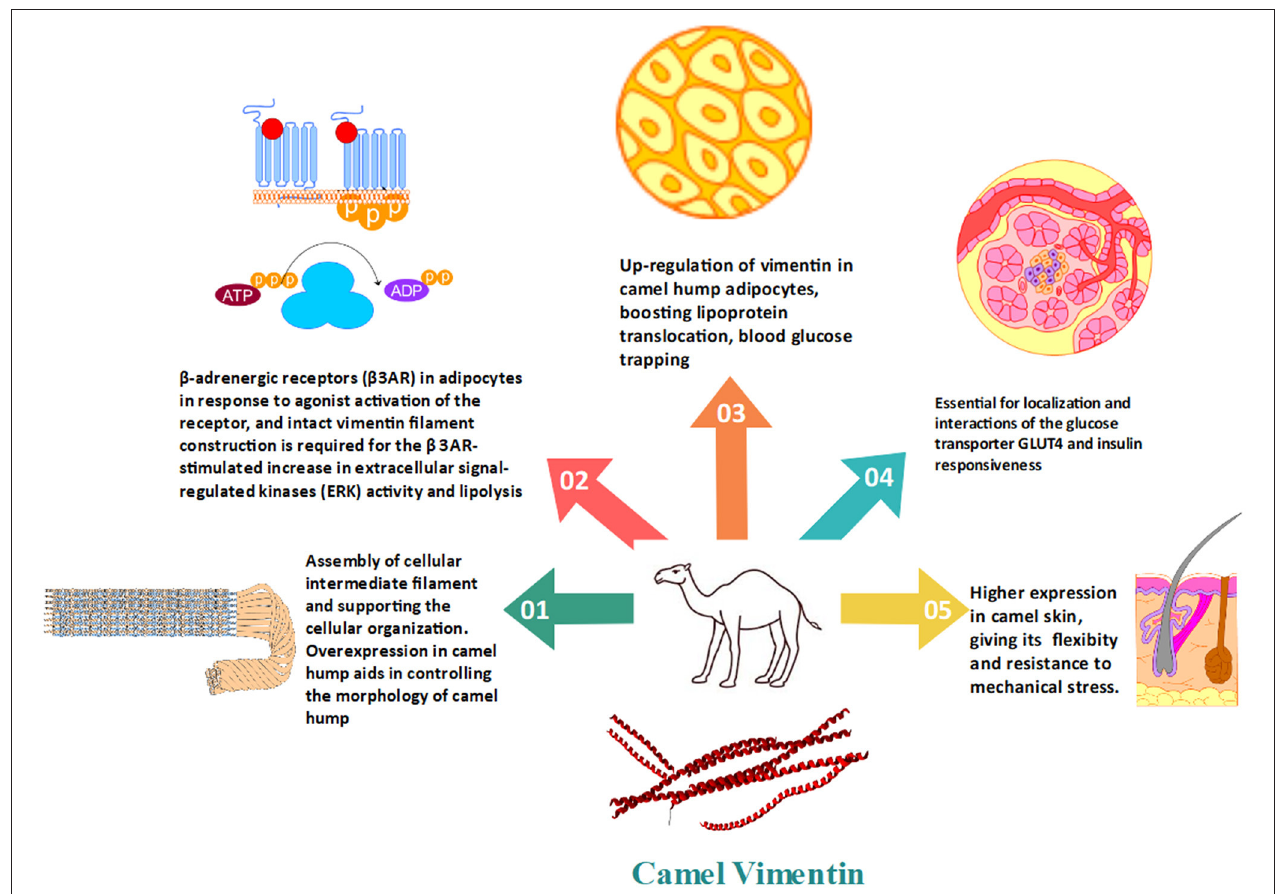
FIGURE 3 | The importance of vimentin in the regulation of fat and glucose metabolism in camels as well as the conventional cytoskeleton formation.